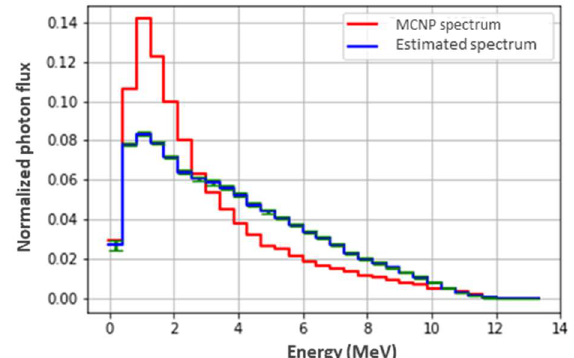
Fig. 13. Comparison of the average energy spectrum estimated from the experimental transmission curve obtained with the SATURNE accelerator (in blue) and the reference spectrum from the MCNP6.1 simulations (in